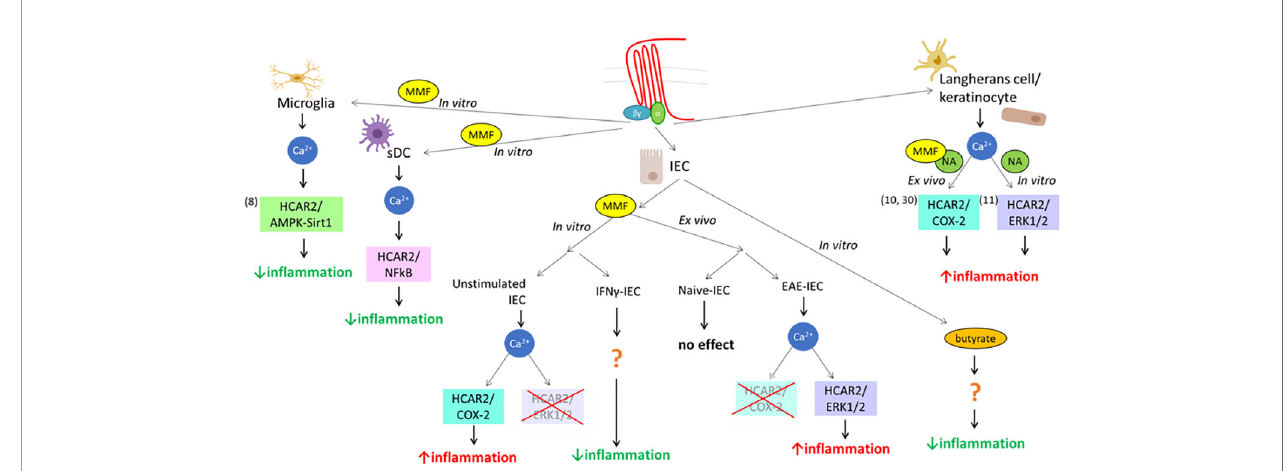
FIGURE 7 | Scheme representing the cell, ligand, and environmental biases of HCAR2 signaling. This scheme summarizes the various biases of the pleiotropically linked receptor for MMF, HCAR2, at system and ligand levels, from data obtained in this and previous studies. It shows the usage of three different pathways used in three different cell types (microglia, DC, and IEC) in vitro upon triggering of HCAR2 by MMF, with different outcomes (decrease or increase of in fl ammatory pro fi le of the cell) associated with the different pathways; the impact of the environment ( in vitro vs in vivo , under resting or in fl ammatory conditions) on MMF signaling; and the differential outcome/signaling by different ligands (MMF, NA,